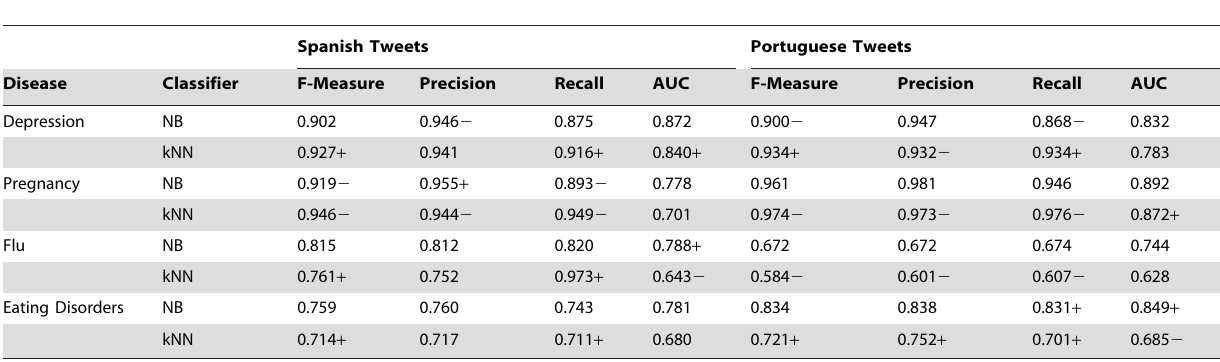
Table 8. Classification results obtained on subsets generated using Pearson